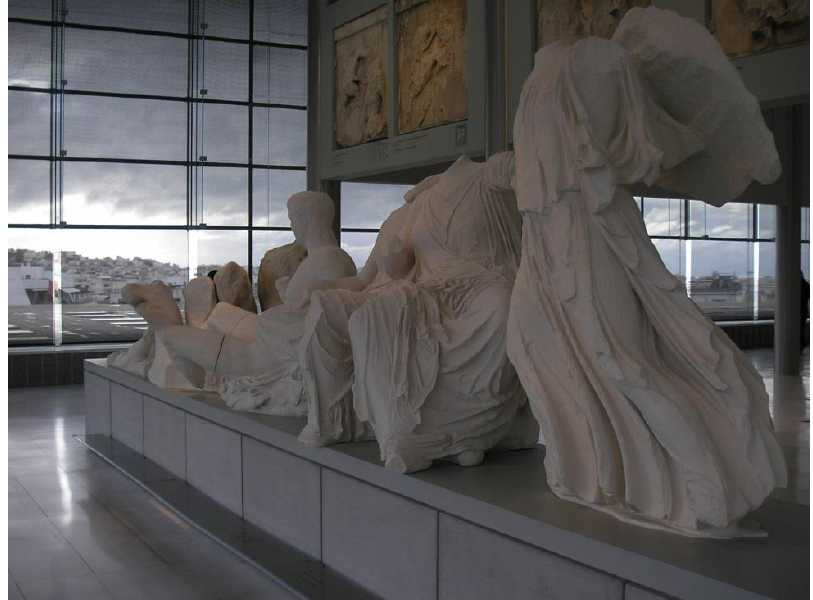
Figure 6. The casts of the pediment statues from the southern end of the east side of the Parthenon, with the original Pentelic marble metopes behind. Note that, despite the overcast skies of early December, there are blinds on the windows. The sculptures are clearly denied unimpeded access to the natural daylight; contrast the brightness of the single narrow ray of daylight penetrating through a gap in the blinds and across the floor of the Parthenon Gallery compared to the more muted light that has to pass through the black mesh of the blinds. The Marbles on display along the southern side of the New Acropolis Museum (facing out over the modern cityscape rather than towards the ancient monuments on the Acropolis) are instead viewed in considerably more shaded conditions than would be the case were they in their original positions on the exterior of the Parthenon. Photograph: J. Beresford. Reproduced with the permission of the Acropolis